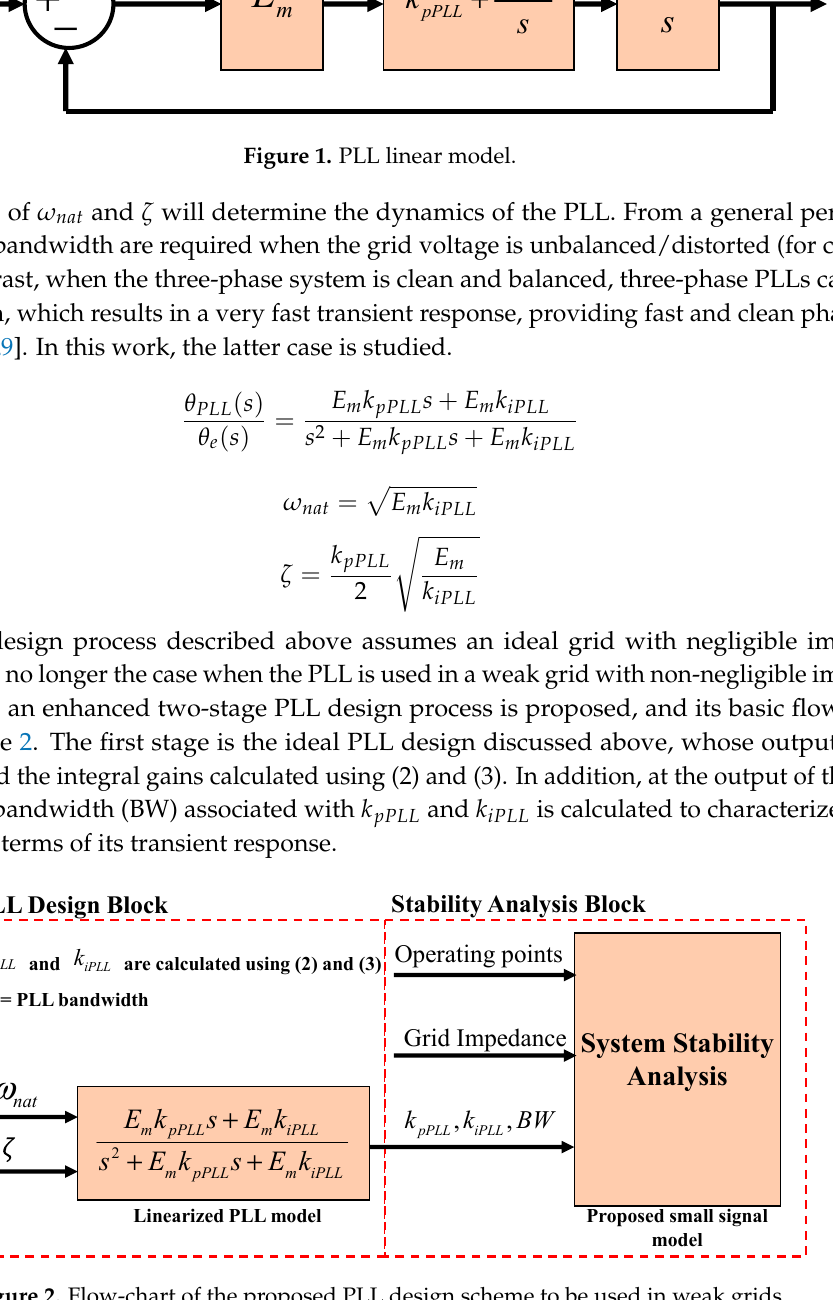
Figure 2. Flow-chart of the proposed PLL design scheme to be used in weak grids.